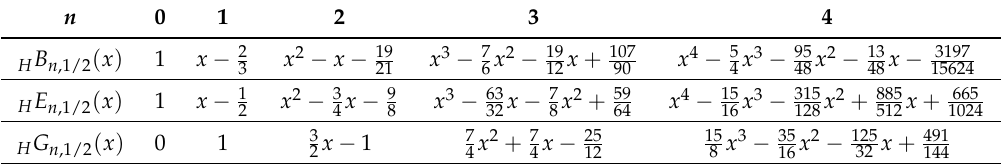
Table 6. Expressions of first five H B n ,1/2 ( x ) , H E n ,1/2 ( x ) and H G n ,1/2 ( x ) .